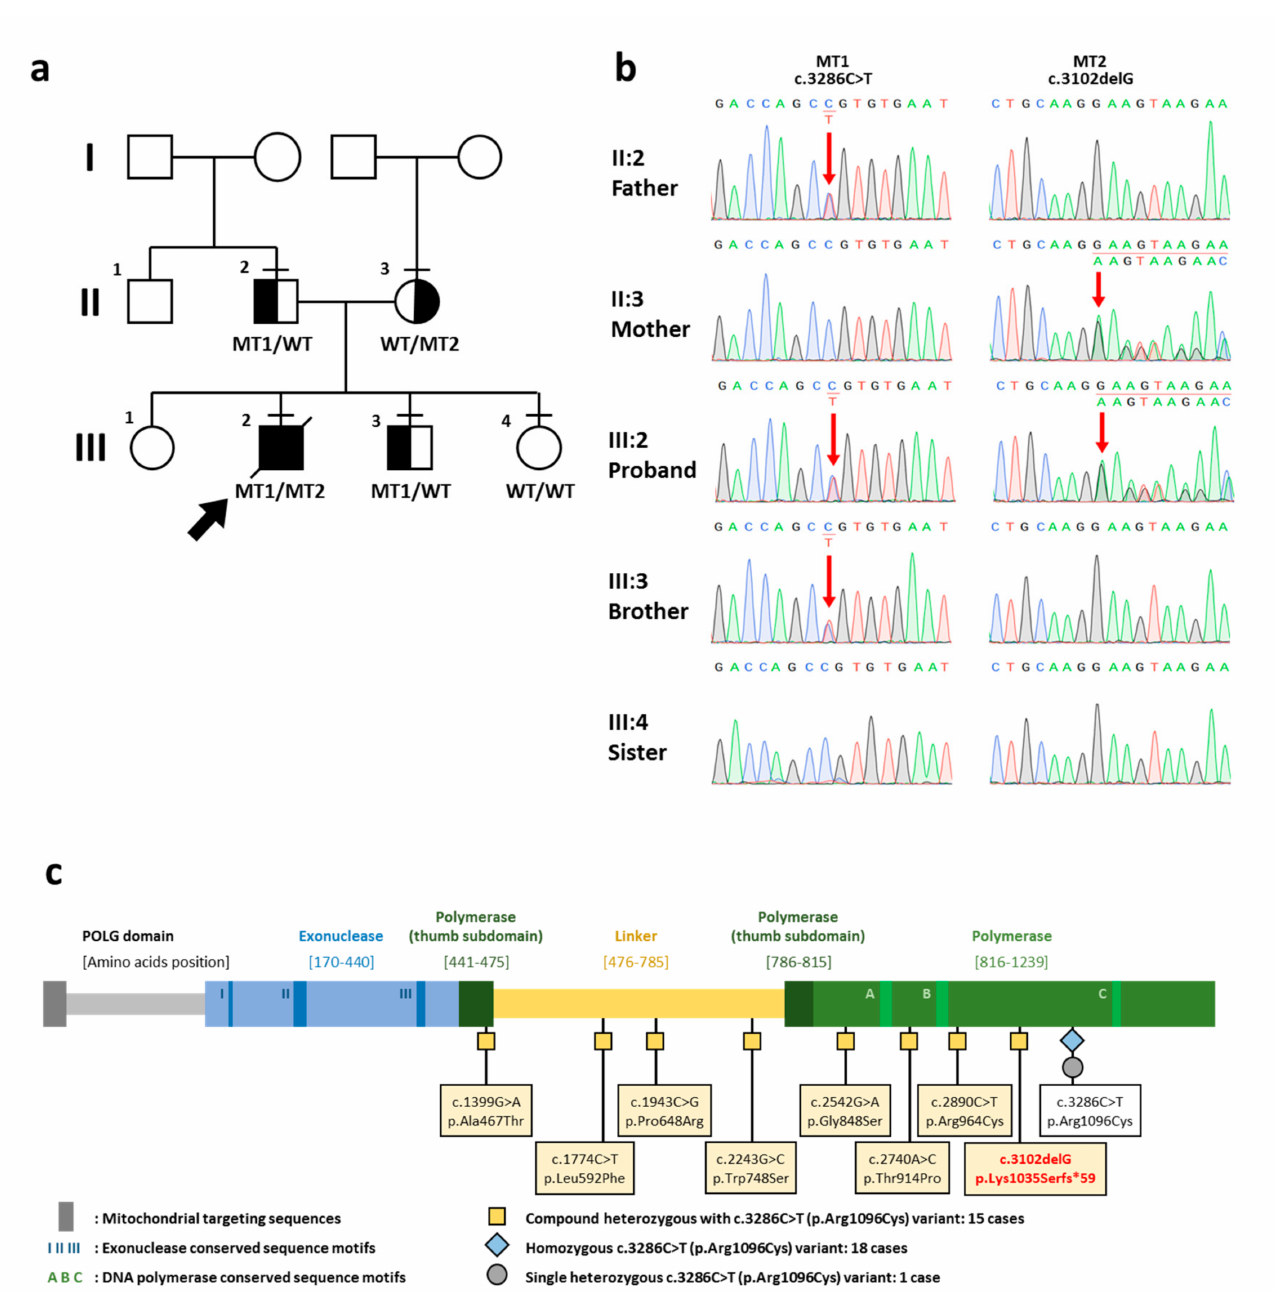
Figure 1. Family pedigree, chromatograms, and schematic diagram of the POLG protein. ( a ) Family pedigree. The proband is indicated by an arrow. A horizontal line above each symbol indicates the family members participated in genetic testing. ( b ) Chromatograms show that the proband possesses the compound heterozygous variants, c.3286C>T and c.3102delG, in POLG (NM_002693.3). The heterozygous variant, c3286C>T, is observed in the father and the proband’s younger brother. The heterozygous variant, c.3102delG, in POLG is present in the mother. Red arrows indicate the POLG variants. The younger sister possesses two normal alleles. ( c ) Schematic diagram of the POLG protein. The POLG variants reported to be compound heterozygous with the c.3286C>T (p.Arg1096Cys) variant are tagged with yellow square. The homozygous and single heterozygous c.3286C>T (p.Arg1096Cys) variants are tagged with blue diamond and grey circle, respectively. The novel c.3102delG (p.Lys1035Serfs*59) variant identified in the proband is shown in red letters. Functional domain is demonstrated above the diagram. I, II, and III indicate the conserved sequence motifs for 3 (cid:48) –5 (cid:48) exonuclease function. A, B, and C indicate the conserved sequence motifs for DNA polymerase function. WT, wild type allele; MT1, c.3286C>T allele; MT2, c.3102delG